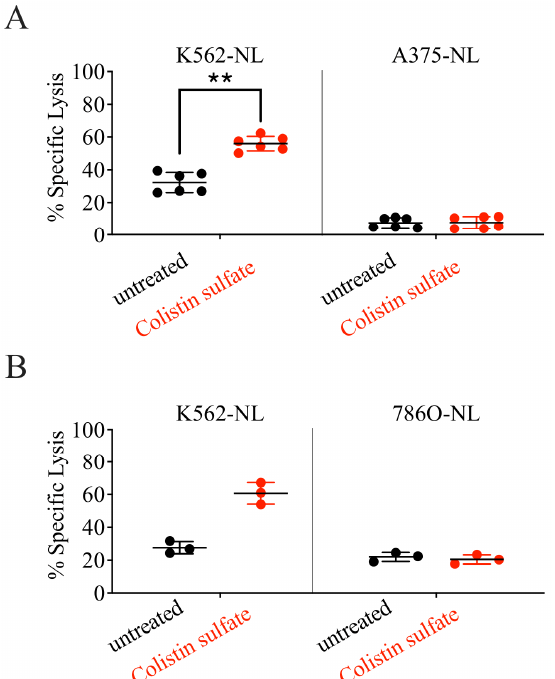
Figure 6. Treatment with Colistin sulfate failed to increase NK92-mediated killing of non-hematopoietic cell lines. NK92 and K562-NL/A375-NL ( A ) or K562-NL/786O-NL ( B ) cells were seeded into a 96-well V bottom plate at a 1:1 E:T ratio with 10,000 target cells per well and treated with 10 μ M of colistin for 5-h at 37 °C. After incubation, the supernatant was collected and transferred to a 96-well black plate. The Biotek Synergy microplate reader (Winooski, WI, USA) was used to dispense CTZ and read luminescence. Percent specific lysis is depicted. Each dot represents a technical replicate, experiments were repeated twice. Two-tailed Mann–Whitney test. **: p < 0.01.